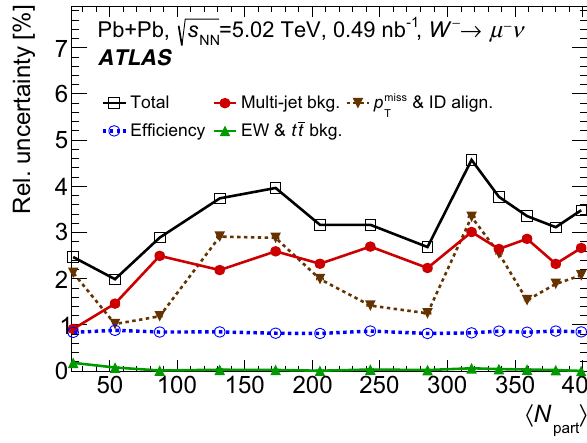
〉 N 〈 part reconstructionandIDmisalign- ciencycorrections(“Efficiency”), p miss T ment uncertainties (“ p miss and ID align”), as well as the uncertainties T related to the estimation of EW and top-quark backgrounds (“EW and t ¯ t bkg”), are added in quadrature